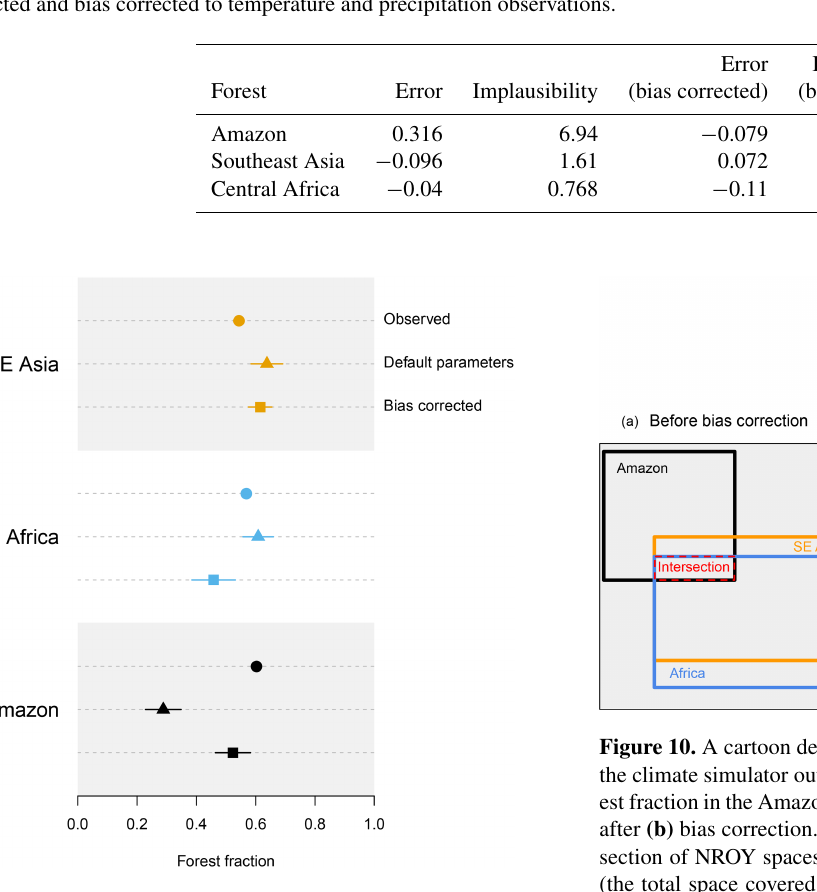
Figure 9. Observed and emulated forest fraction in each tropical forest. For the emulated forest fraction at default and bias-corrected parameters, emulator uncertainty of ± 2SD is represented by hori- zontal bars.